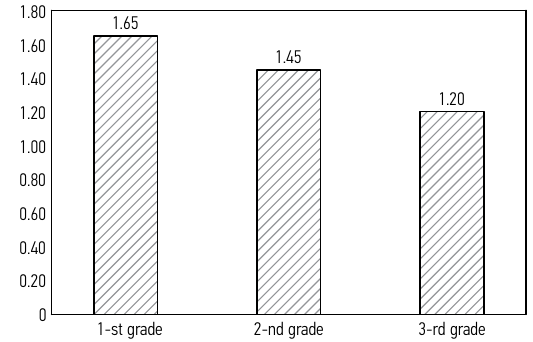
Fig. 3. Quality factor of slags by grades, according to the Table 3. Physical and mechanical characteristics of crushed material produced from electric steel-smelting slag Indicator